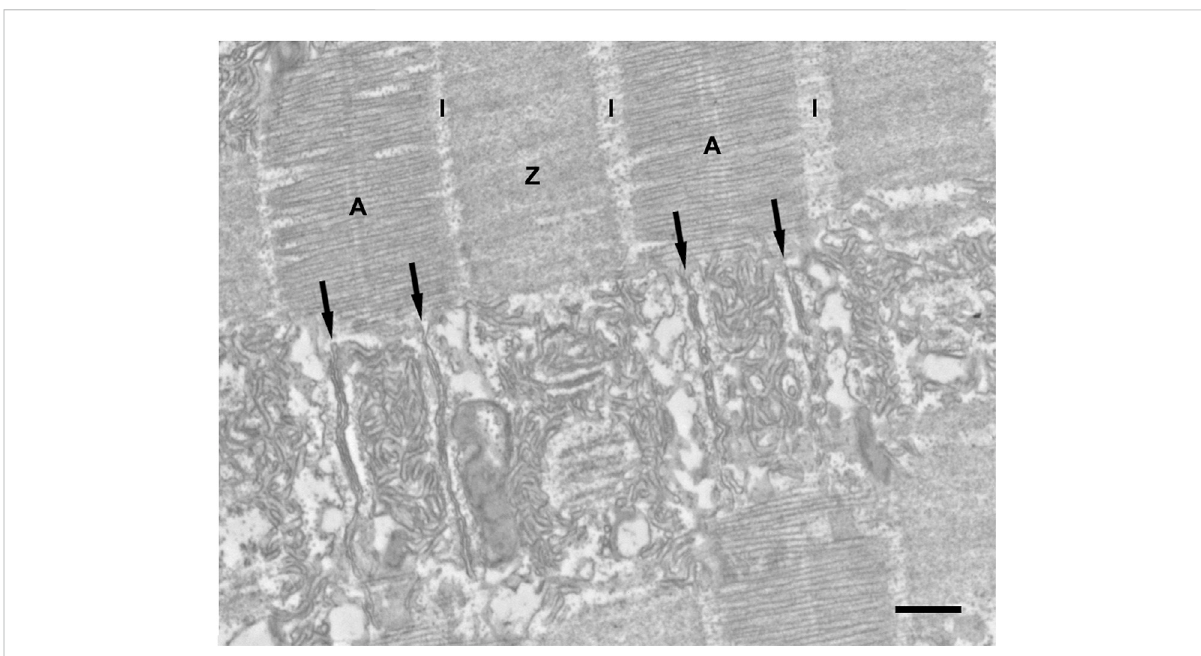
FIGURE 1 Representative EM image in longitudinal section of a sonic swimbladder muscle fi ber from a territorial male midshipman. The upper part of the image shows the fi ber cross striation. The A bands (A) alternate with Z bands (Z) of approximately equal width. The I band (I) is pale and very narrow because mostof thethin fi laments ovarlapwith thethick fi laments in theA band. In thelower half ofthe image, thethin sectionplanecoincides with thelayerofSR.Incorrespondenceofeachsarcomere,twotriads(blackarrows)arelocatedatapproximatelyone-third ofthedistancebetween thecenterandtheedgesoftheAband.TheSRformsanabundantconvolutednetwork overthecenteroftheAbandandoverthelateralsidesofthe sarcomere. Scale bars: 0.5 μ